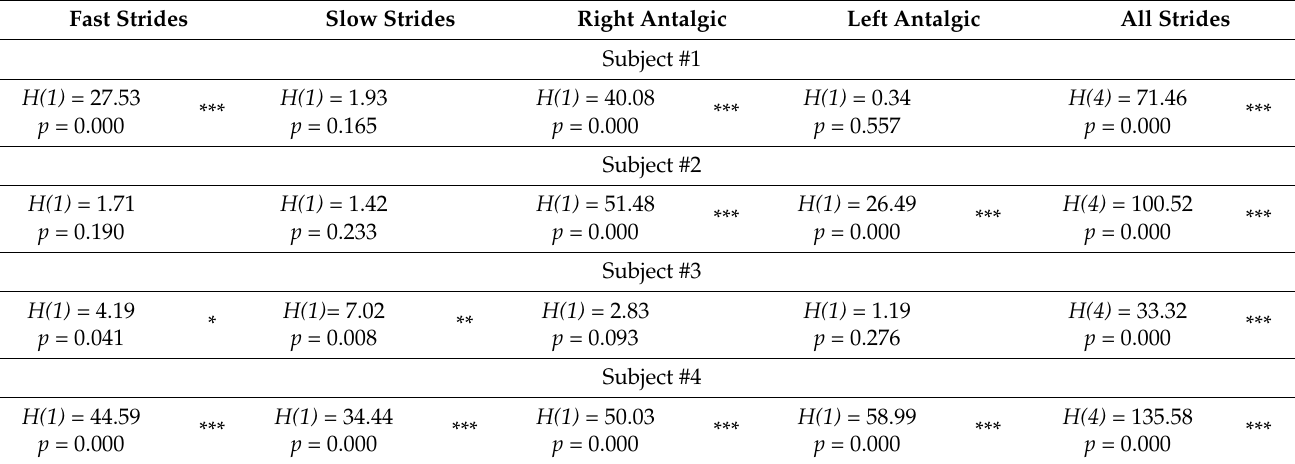
Table 6. Detection of Abnormal or Irregular Strides Using Leg Gap (Kruskal–Wallis test). Fast Strides Slow Strides Right Antalgic Left Antalgic All Strides